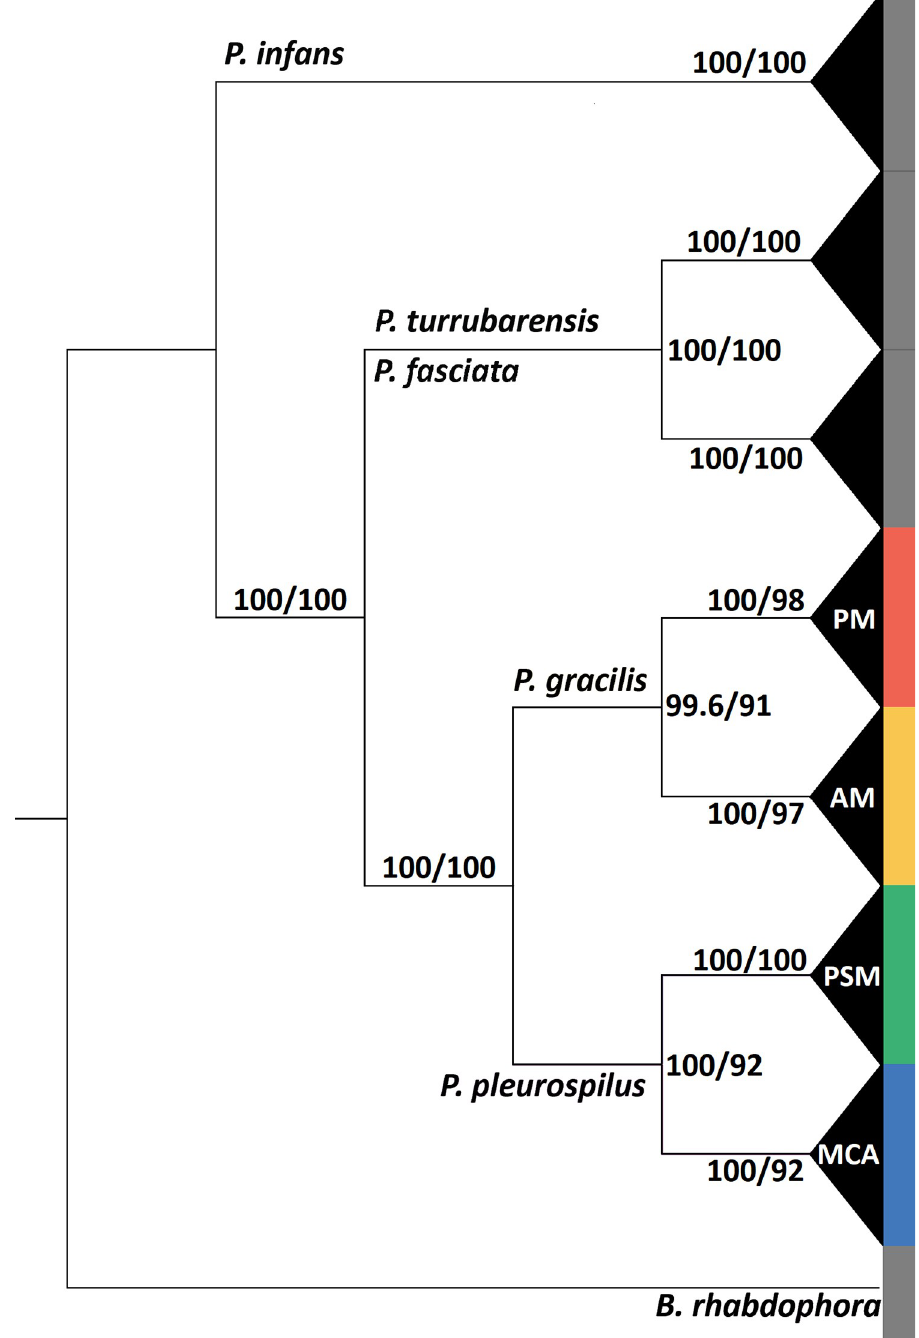
Fig 2. Collapsed ddRADseq cladogram with SH-aLRT (left) and ultrafast bootstrap (right) values. Colorized clades indicate P . gracilis (PM; AM) and P . pleurospilus (PSM;